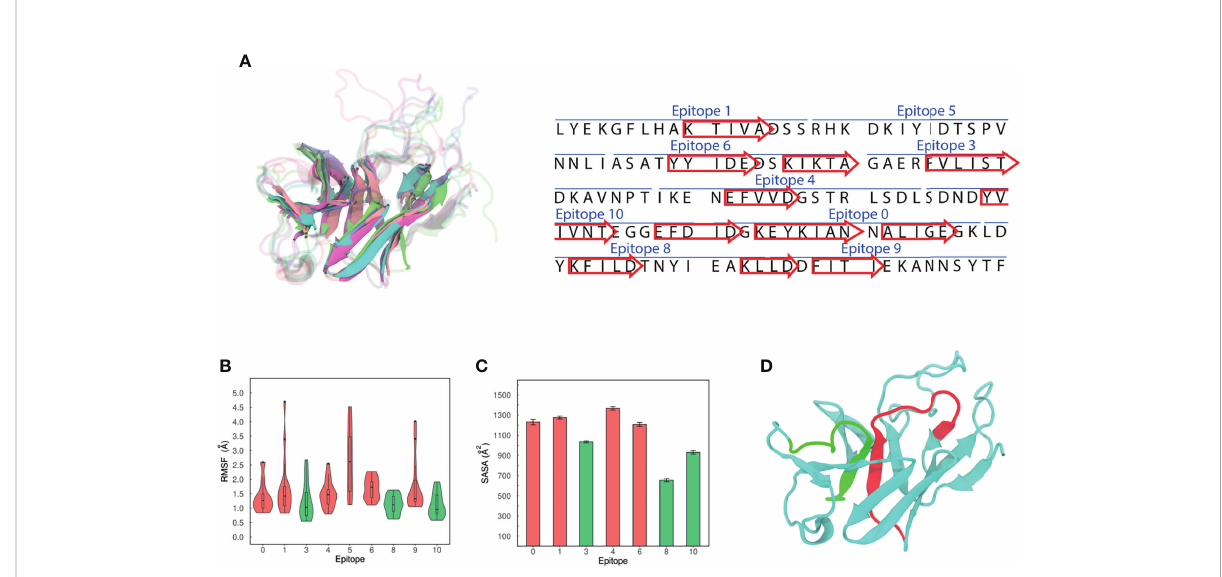
FIGURE 8 Structural characteristics of MEP_12. (A) Alignment of the 3D structures of MEP_12 from all the centroids of the fi ve most populated clusters. Cyan, purple, orange, green, and pink cartoons correspond to the centroids of clusters 1, 2, 3, 4 and 5 respectively. The twelve b -strands in the structure (left) are represented as arrows in the sequence (right). (B) Violin plots showing the distribution of Ca-RMSF values. The lowest Ca- RMSF distributions are colored in green. (C) Mean SASA by epitope. The error bars represent 95% con fi dence intervals. (D) Modeled structure of MEP_12, showing epitopes “ 3 ” and “ 6 ” in red and green,